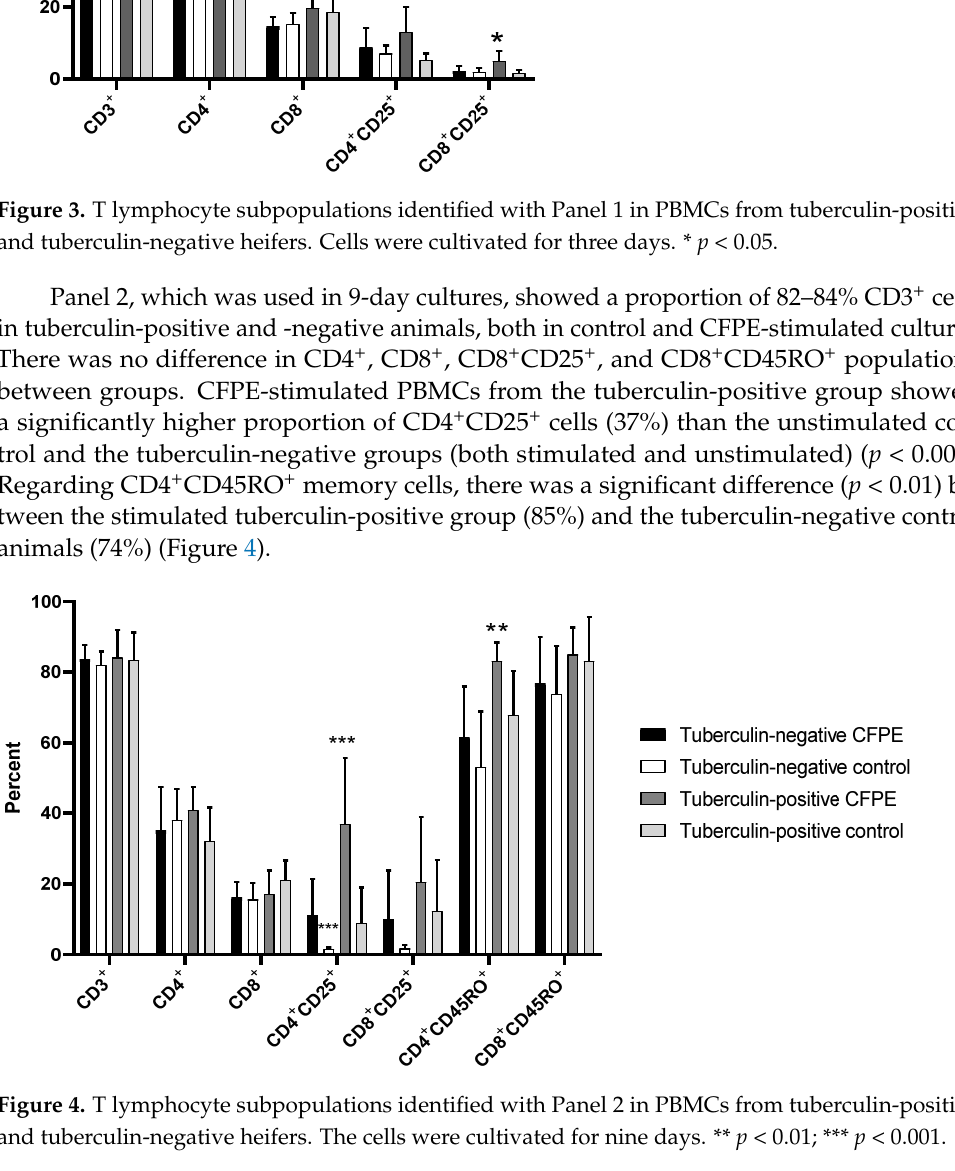
The CD3 + CD4 − CD8 − cell population was found in both panels in a high